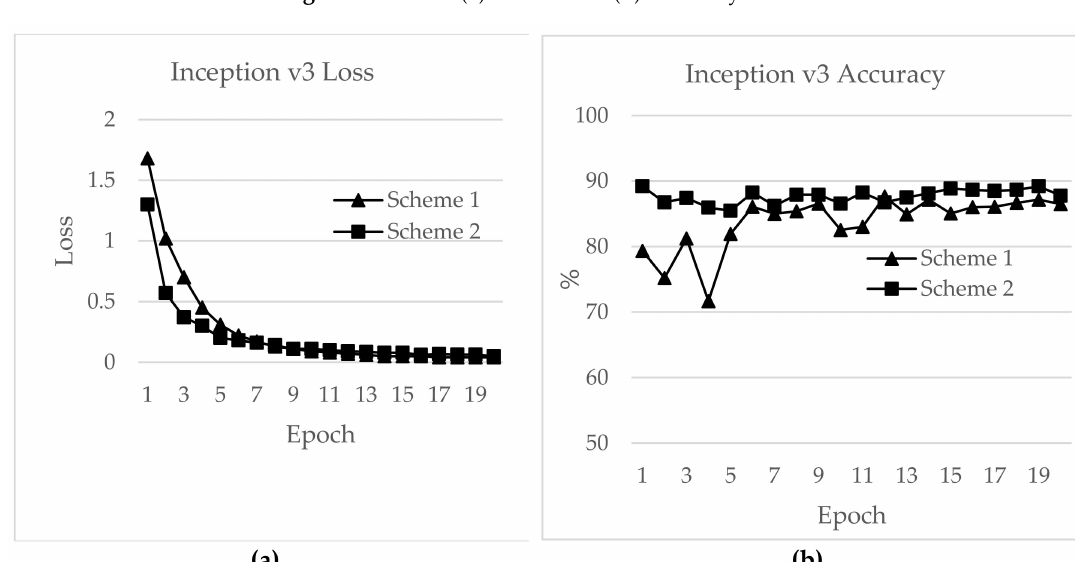
Figure 20. Inception v3 ( a ) loss curves and ( b ) accuracy